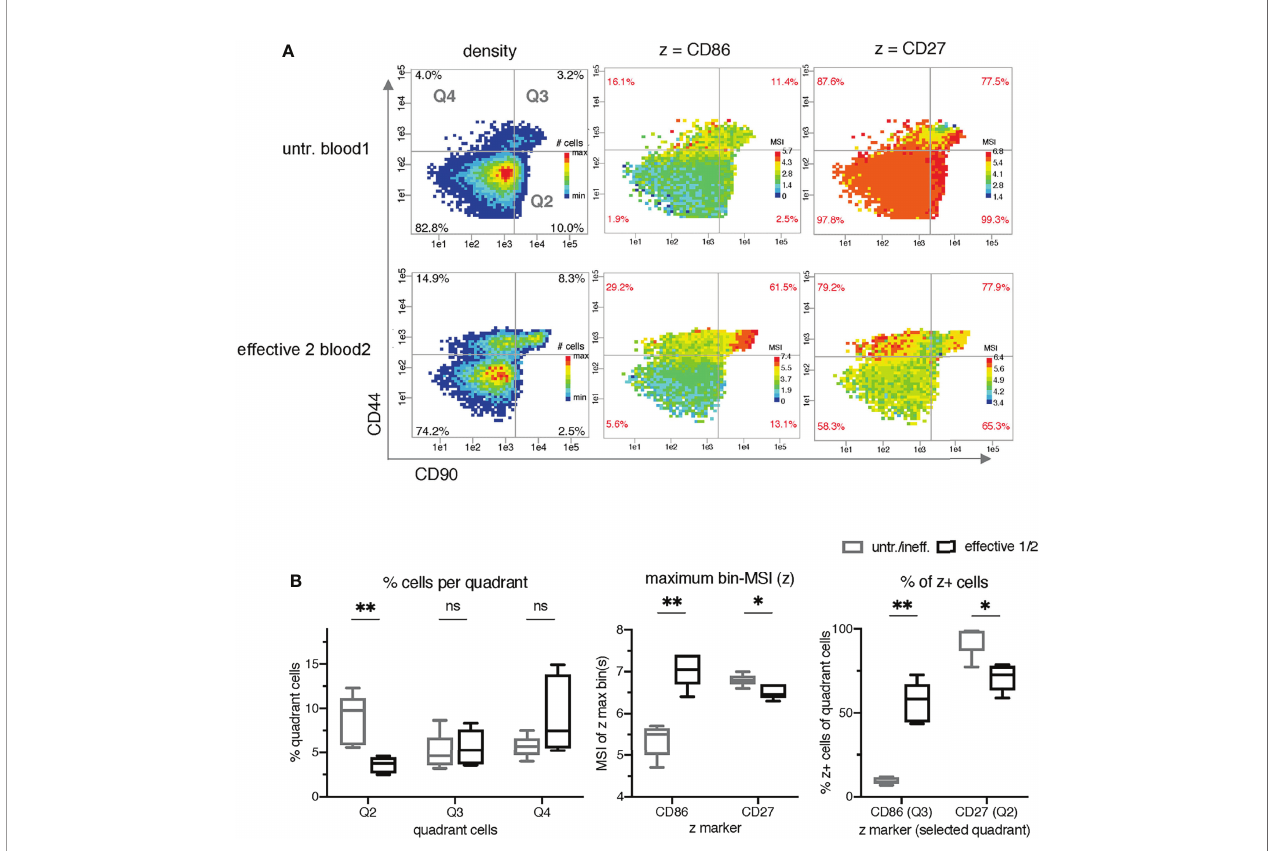
FIGURE 3 | Identi fi cation of intensity bin-patterns and bin-values for the classi fi cation of mice receiving treatments with differential effects. (A) Comparison of the density and mean signal intensity (MSI)-bin patterns of two exemplary samples (untreated blood1 and effective 2 blood2) using semi-continuous binning with CD90 (x-axis) and CD44 (y-axis) and dynamic intensity ranges for z. (B) Statistical comparison of three different metrics as z parameter in PRI per sample: the frequency of the quadrant cells (left graph; black quadrant numbers of density plots), the maximal bin-MSI values of CD86 and CD27 (middle graph; max-bin values of the color- coded legend of MSI bin plots), and the frequencies of z + cells per quadrants (right graph; red quadrant numbers of MSI-bin plots of all 11 samples). The ineffective treatment group with untreated (untr.) and ineffectively treated (ineff.) samples is shown in gray and the effective treatment group with effective treatment 1 and 2 in black. P < 0.05 was considered signi fi cant, with the numbers of asterisks indicating: *p ≤ 0.05; **p ≤ 0.01; ns stands for non-signi fi